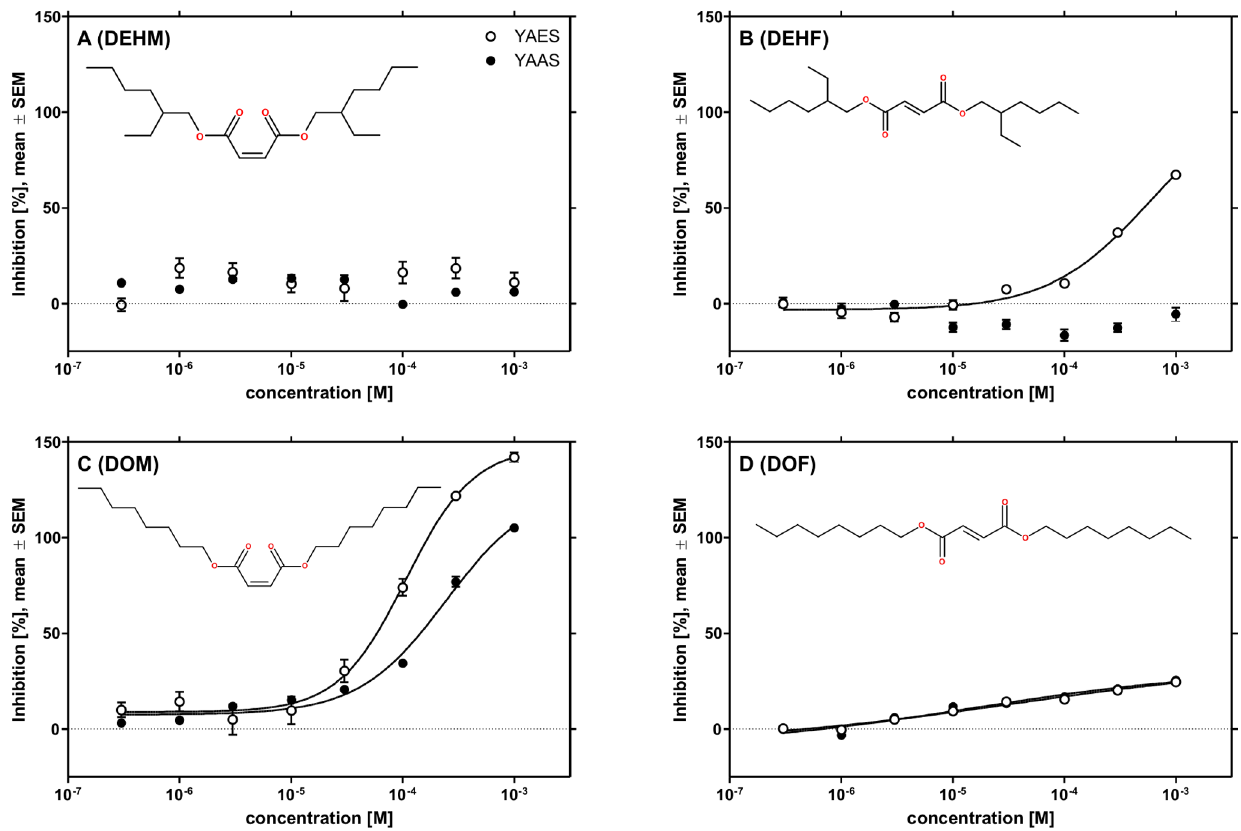
Figure 3. Antiestrogenic and antiandrogenic activity of DEHM (A), DEHF (B), DOM (C), and DOF (D). Data from three experiments with eight replicates each. Dose-response relationships were generated using a four-parameter logistic function.